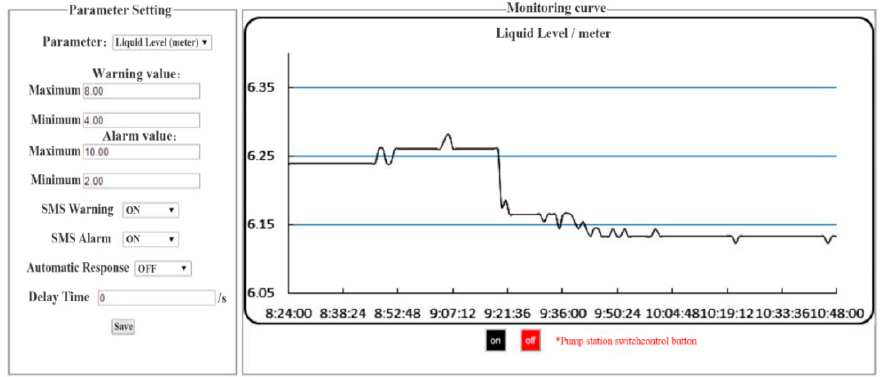
Figure 10. Dynamic monitoring information of brine pumps.